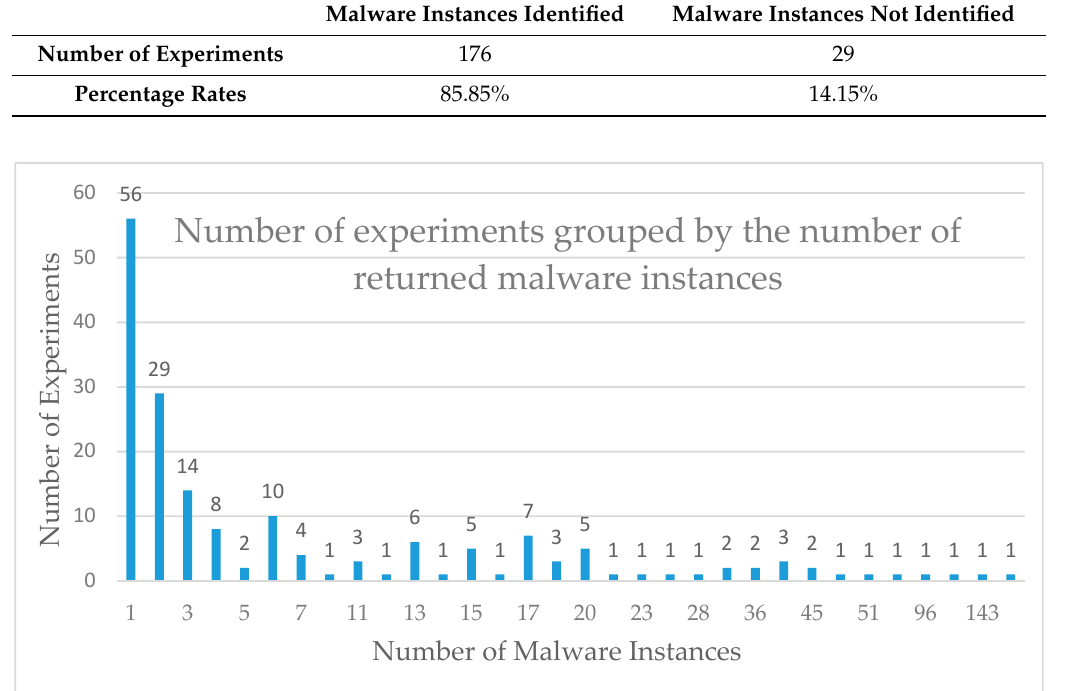
Table 1. Malware instances correctly identified during the experiments.